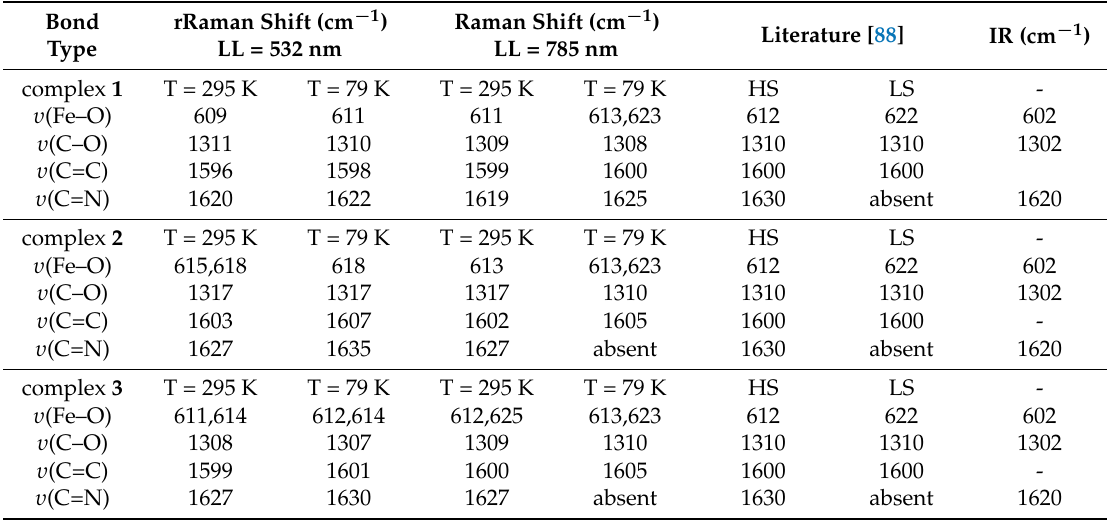
Table 2. Representative Raman shifts and IR stretches of compounds 1 – 3